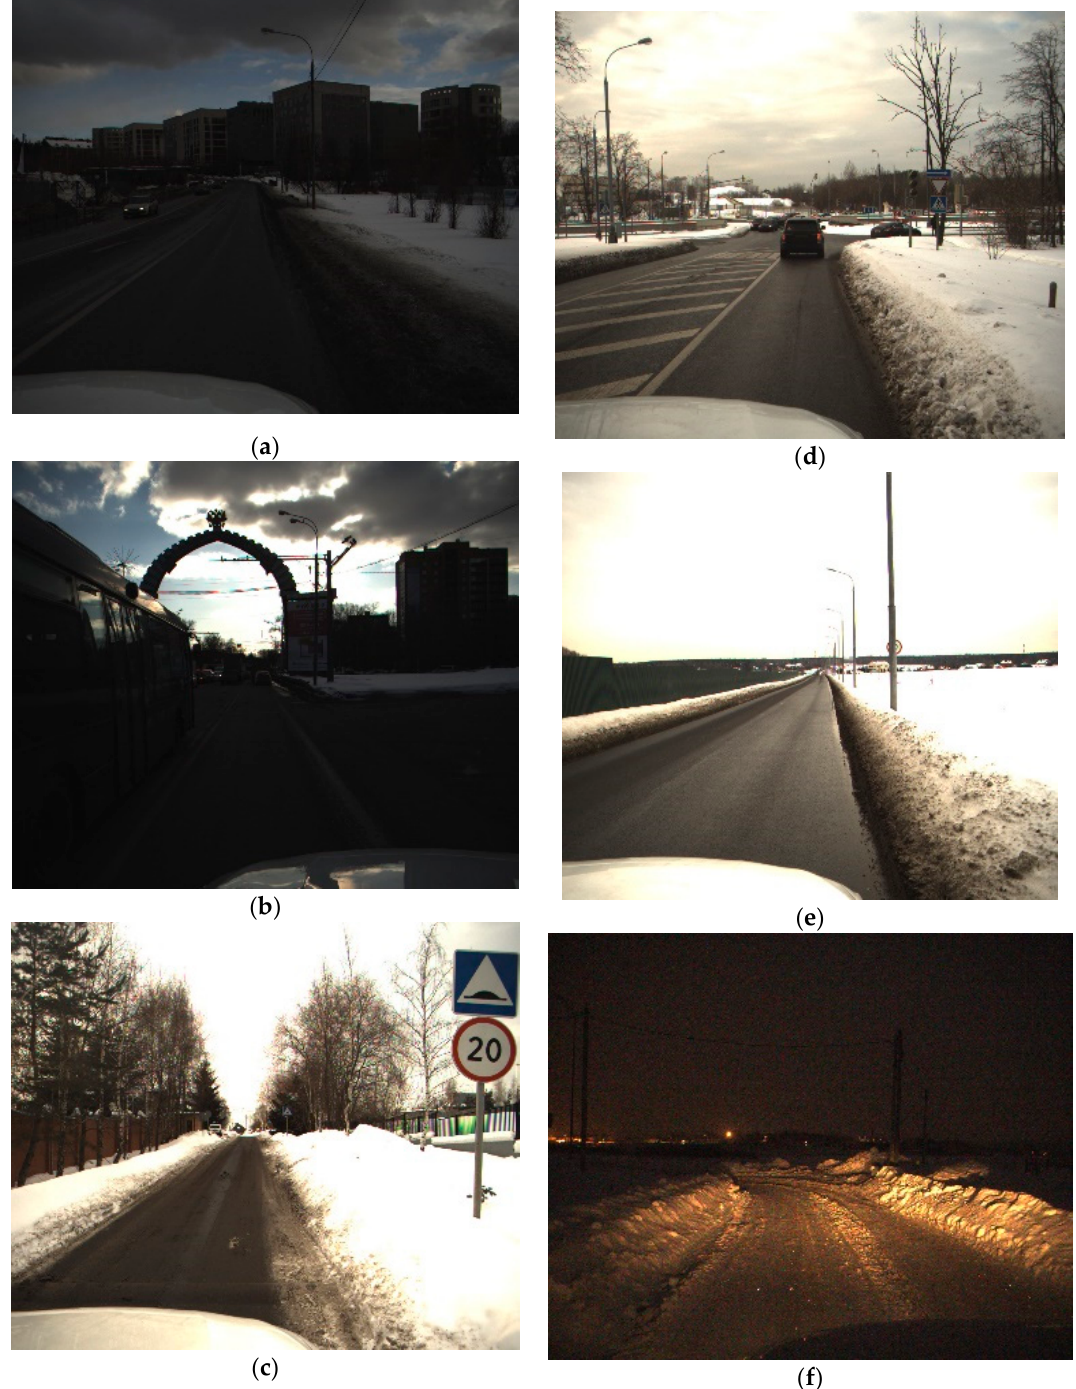
Figure 1. ( a ) Under an ice and snow environment with dark light. ( b ) Under an ice and snow environment with strong reflection. ( c ) Under an ice and snow environment with strong white light. ( d ) Normal. ( e ) Occlusion. ( f ) Night.